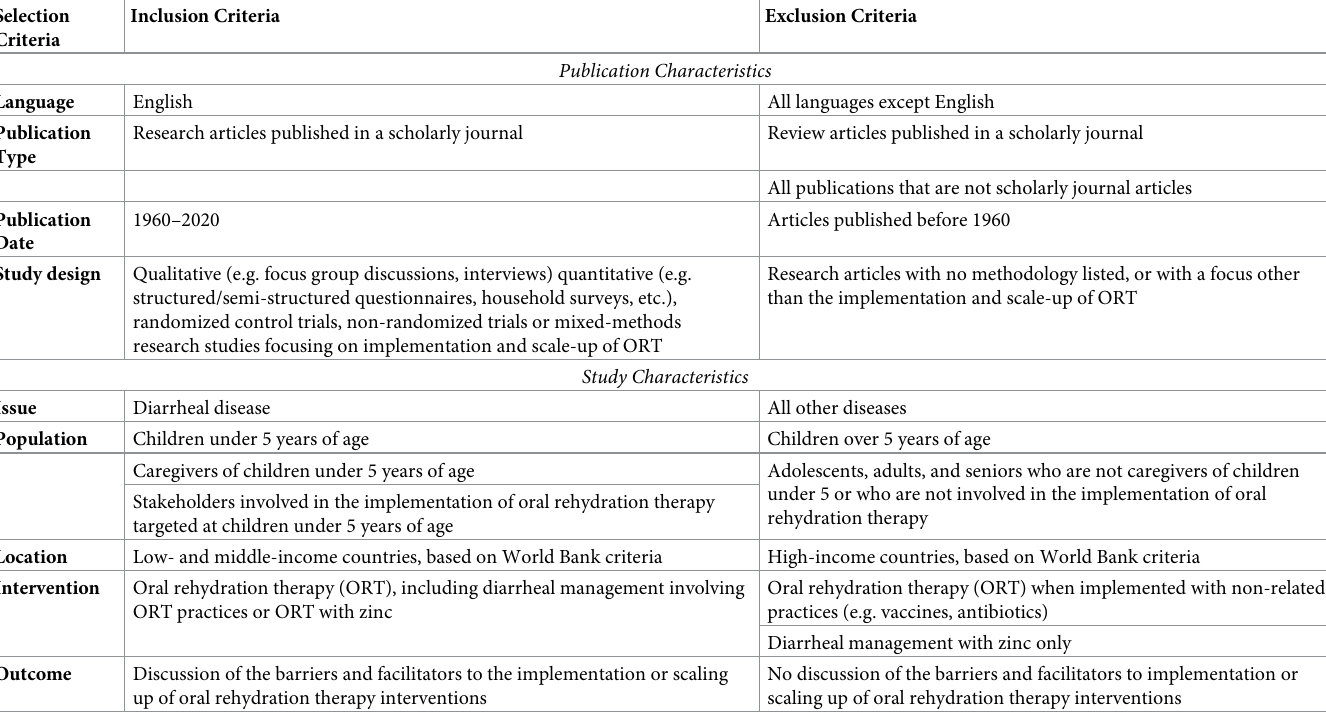
Table 1. Summary of inclusion and exclusion